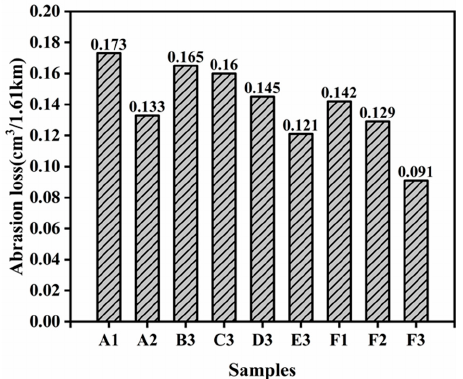
Figure 10. Abrasion loss properties of silica/SSBR/BR composites.